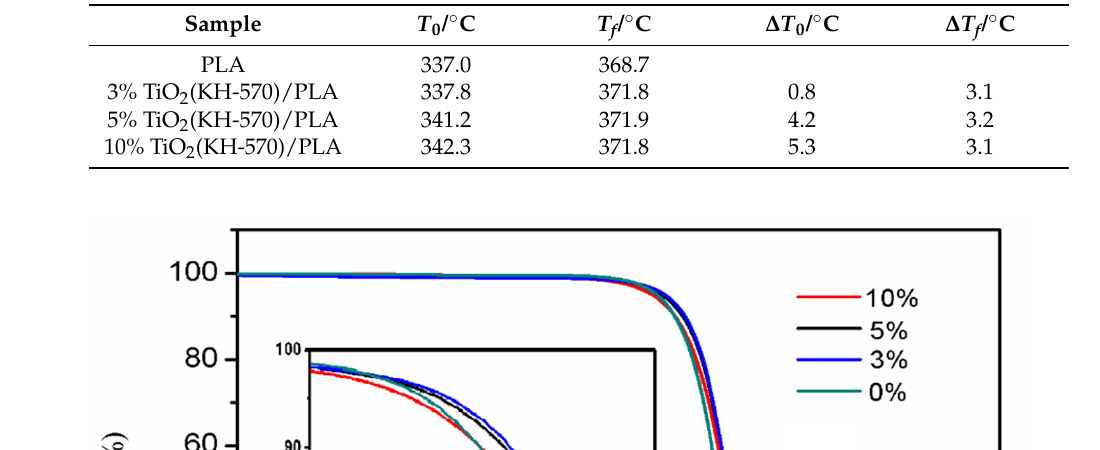
Table 2. TiO 2 content gradient addition amount.